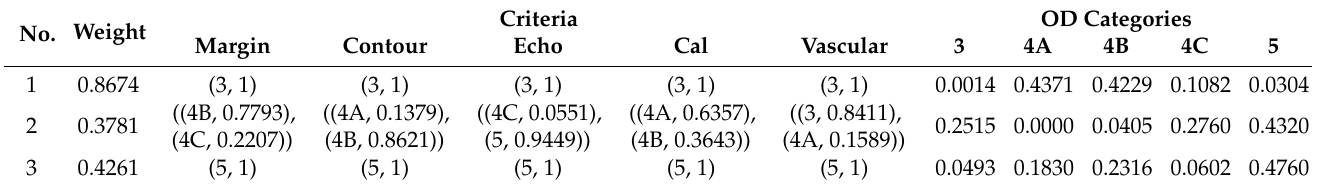
Table 6. BRB of Doctor No. 3 under the distribution assumption.